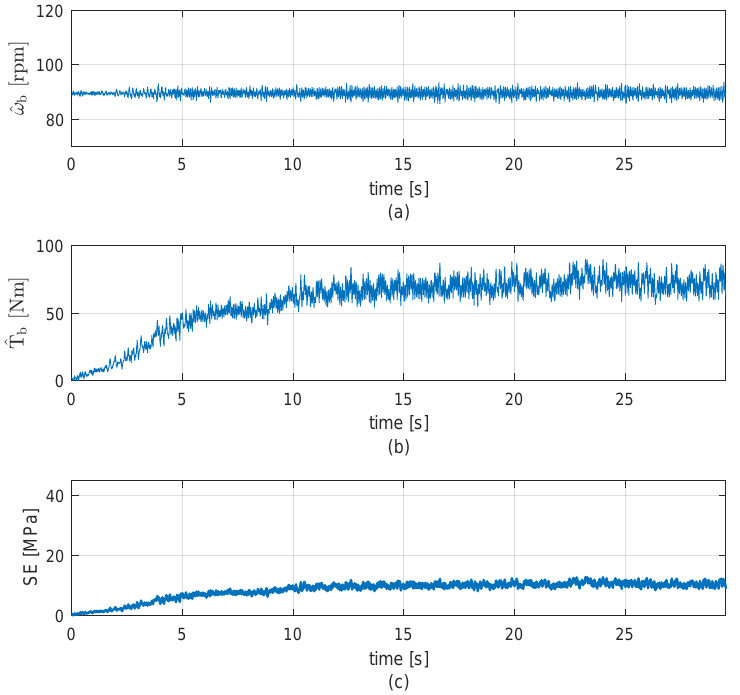
Figure 13. Evaluation of observer-based MWD system during drilling condition of block 2, estimated variables: ( a ) ˆ ω b ; ( b ) ˆ T b ; ( c ) SE .